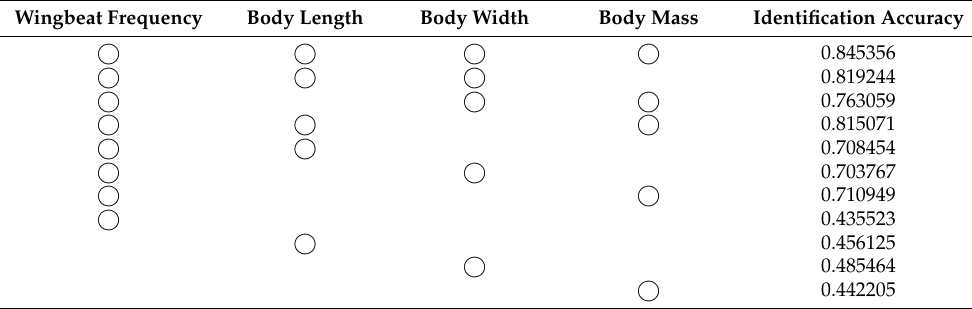
Table 3. The accuracy of classifying insect families by a random combination of four biometric parameters (i.e., wingbeat frequency, body length, body width, and body